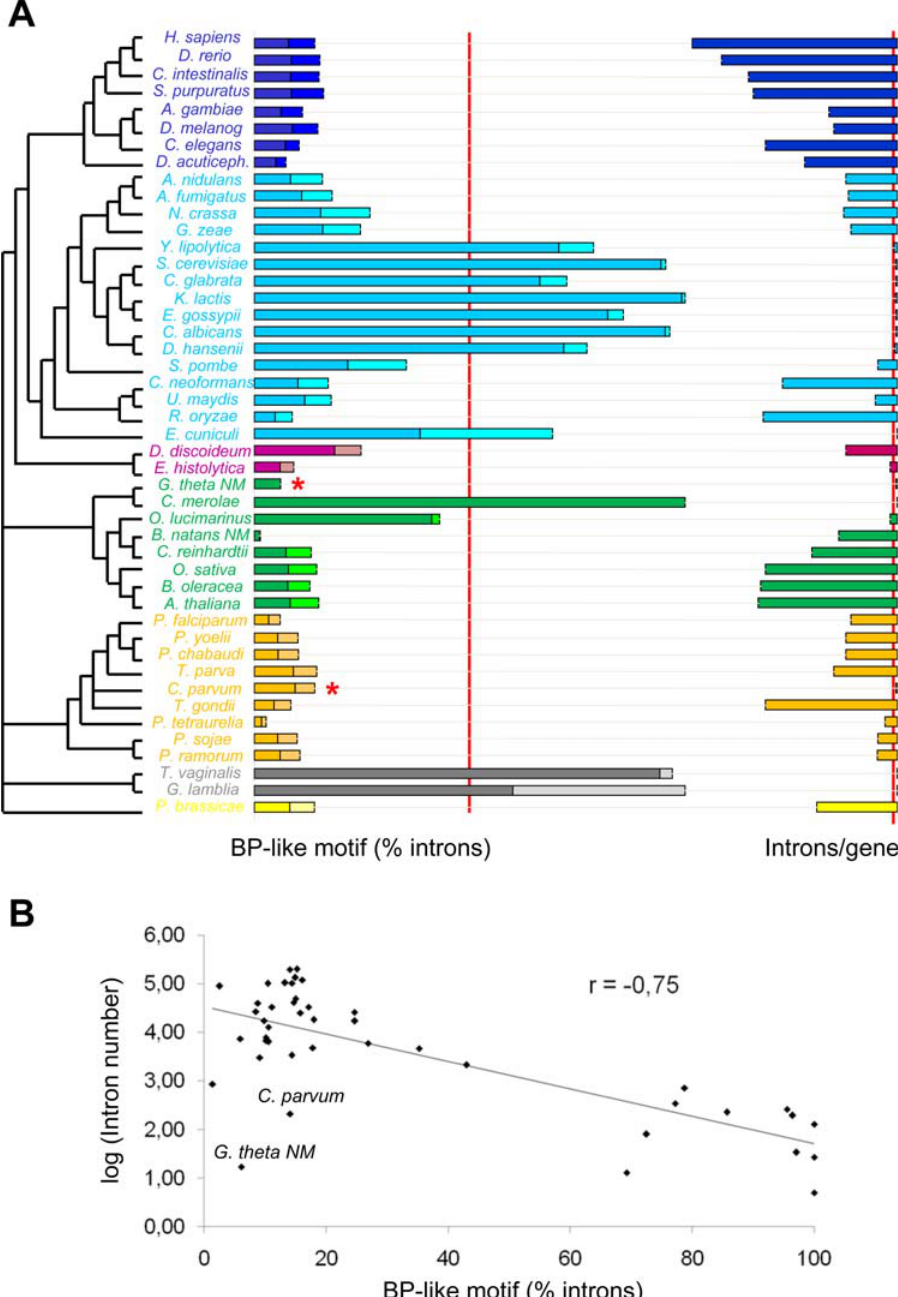
Figure 3. Relation between branch point site consensus strength and intron number. (A) Percentage of introns with the most common BP-like hexamer across eukaryotes. Dark colored bars show the percentage of introns with the most common branch-point hexamer; light colored bars show the additional introns allowing for two-fold degeneracy at one of the six sites. The left red bar separates species with ‘strong’ BP motifs ( . 50% of introns) from species with weaker BP motifs. The right red bar separate extremely intron-poor species ( , 0.15 introns per gene). Asterisks (*) mark the two exception to the correspondence between the two variables (strong BP/intron-poor vs. weak BP/intron-rich). (B) Logarithm of total intron number (Y-axis) and percentage of introns showing the most common potential branch point motif with one site two-fold degeneracy (X-axis) are plotted for all fully sequenced studied genomes. The species cluster in two different groups (with two exceptions) - intron-rich/weak BP consensus, intron-poor/strong BP consensus. The two intron-poor species not showing strong consensus branch points, G. thetha NM and C. parvum , are labeled. The line corresponds to a lineal regression analysis, showing the negative correlation (r= 2 0.75) between intron numbers and branch point consensus conservation. doi:10.1371/journal.pgen.1000148.g003 position -4 (compared to only 39.3% for other introns; p = 0.00004 Exact test). However no clear general trend towards stronger by a Fisher’s Exact test), and 50.0% having an A at position -5 boundaries for short BP-AG introns was observed: introns with a (compared to only 22.0% of other introns; p = 0.002 by a Fisher’s BP-AG distance of 7 nt did now show a stronger 3 9 consensus than